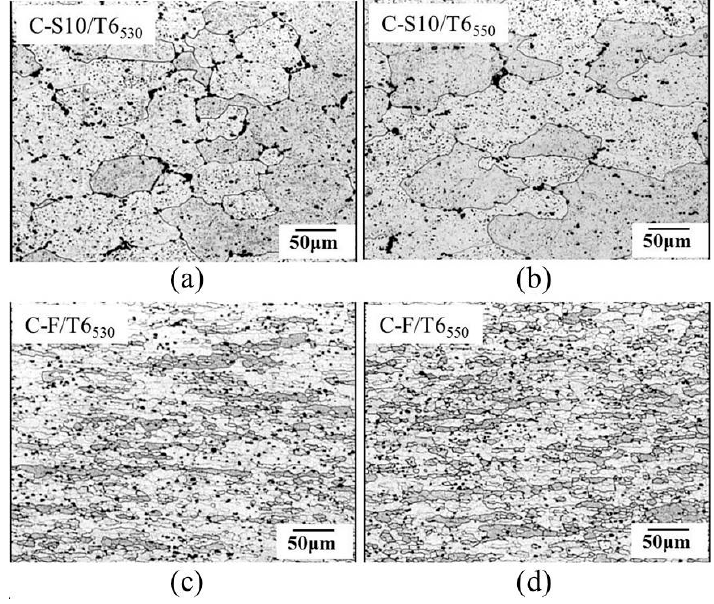
Figure 12. Morphologies of ( a ) C ‐ S10/T6 530 ; ( b ) C ‐ S10/T6 550 ; ( c ) C ‐ F/T6 530 ; and ( d ) C ‐ F/T6 550 .